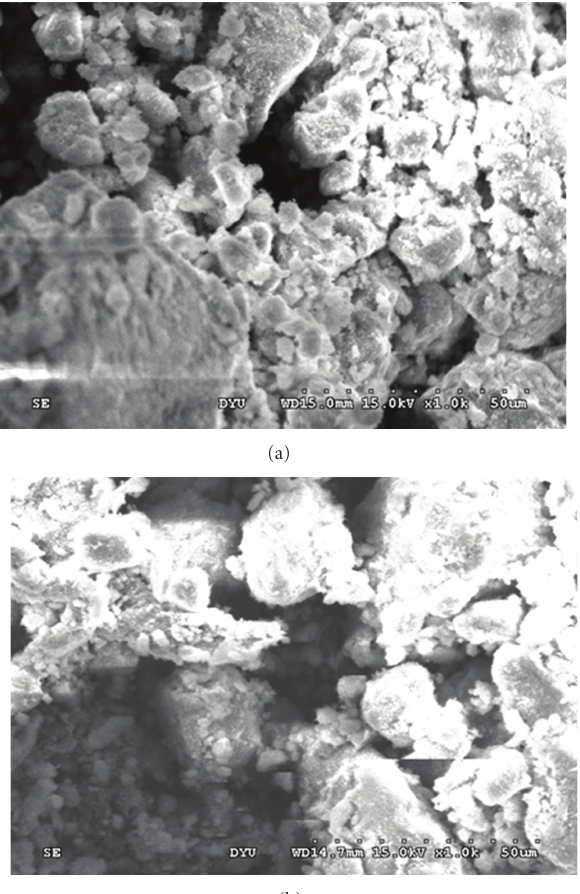
Figure 7: SEM images of 5% Ag/TiO 2 (a) before photoreduction and (b) after photoreduction.